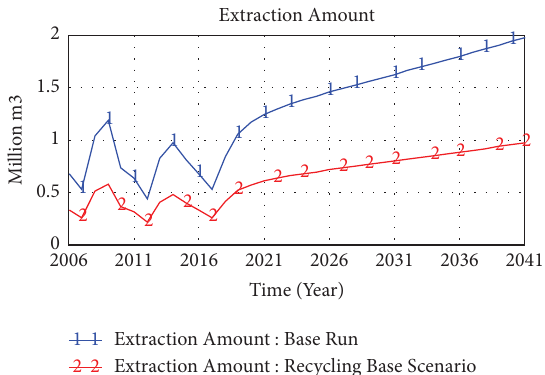
Figure 12: Te trend of stone extraction amount for both options.